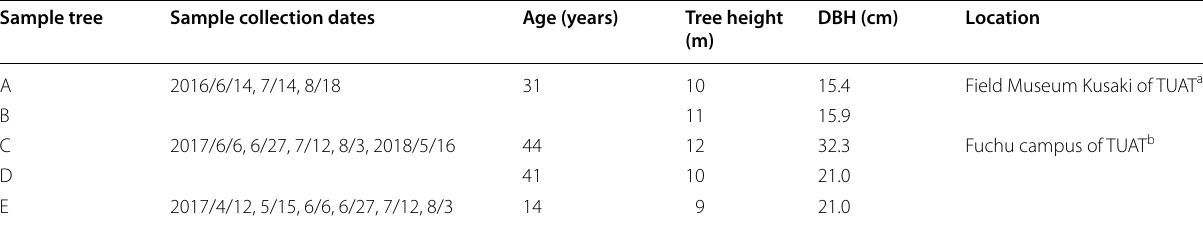
Table 1 Sample collection dates, age, tree height, diameter at breast height (DBH) and location of sample trees Sample